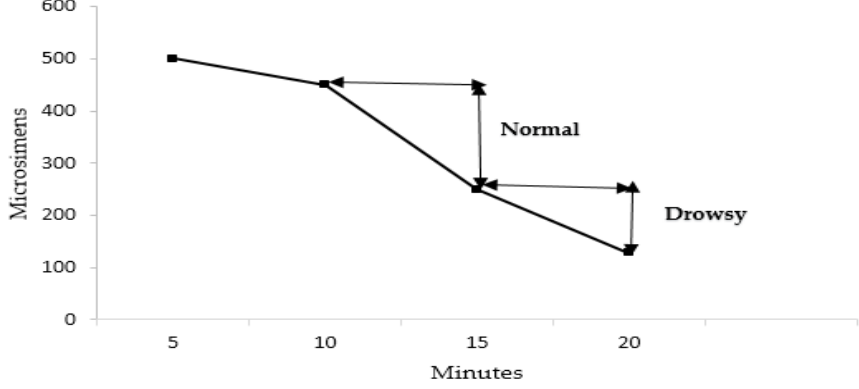
Figure 9. GSR skin conductance value.